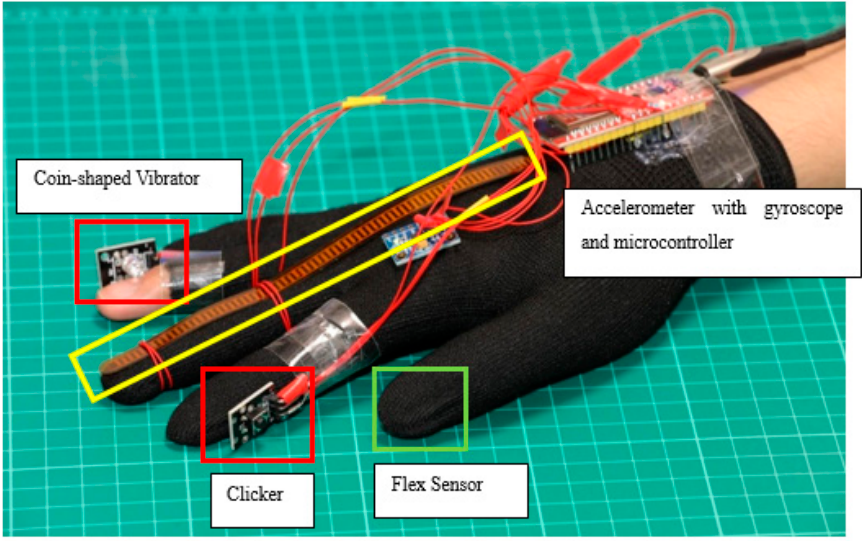
Figure 3. Proposed wearable hand device.